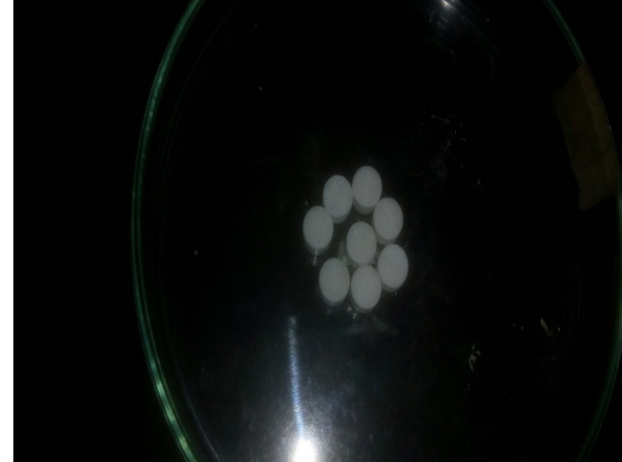
FIGURE 7 - Calcium oxalate crystals. FIGURE 8 - Calcium oxalate tablets.